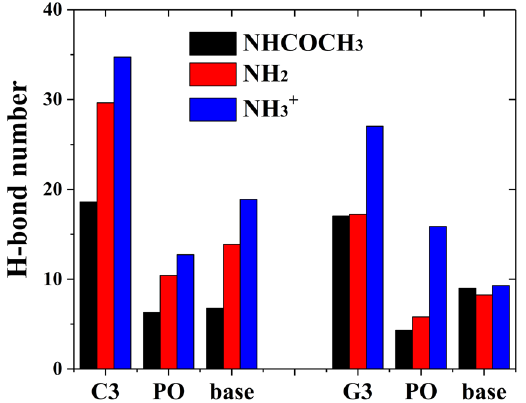
Figure 6. The average number of inter-molecular H-bond between different functional groups and different part of C3 and G3 during the MD simulations (C3/G3: total number of H-bond formed between chitosan and polynucleotides; PO: phosphate; base: guanine or